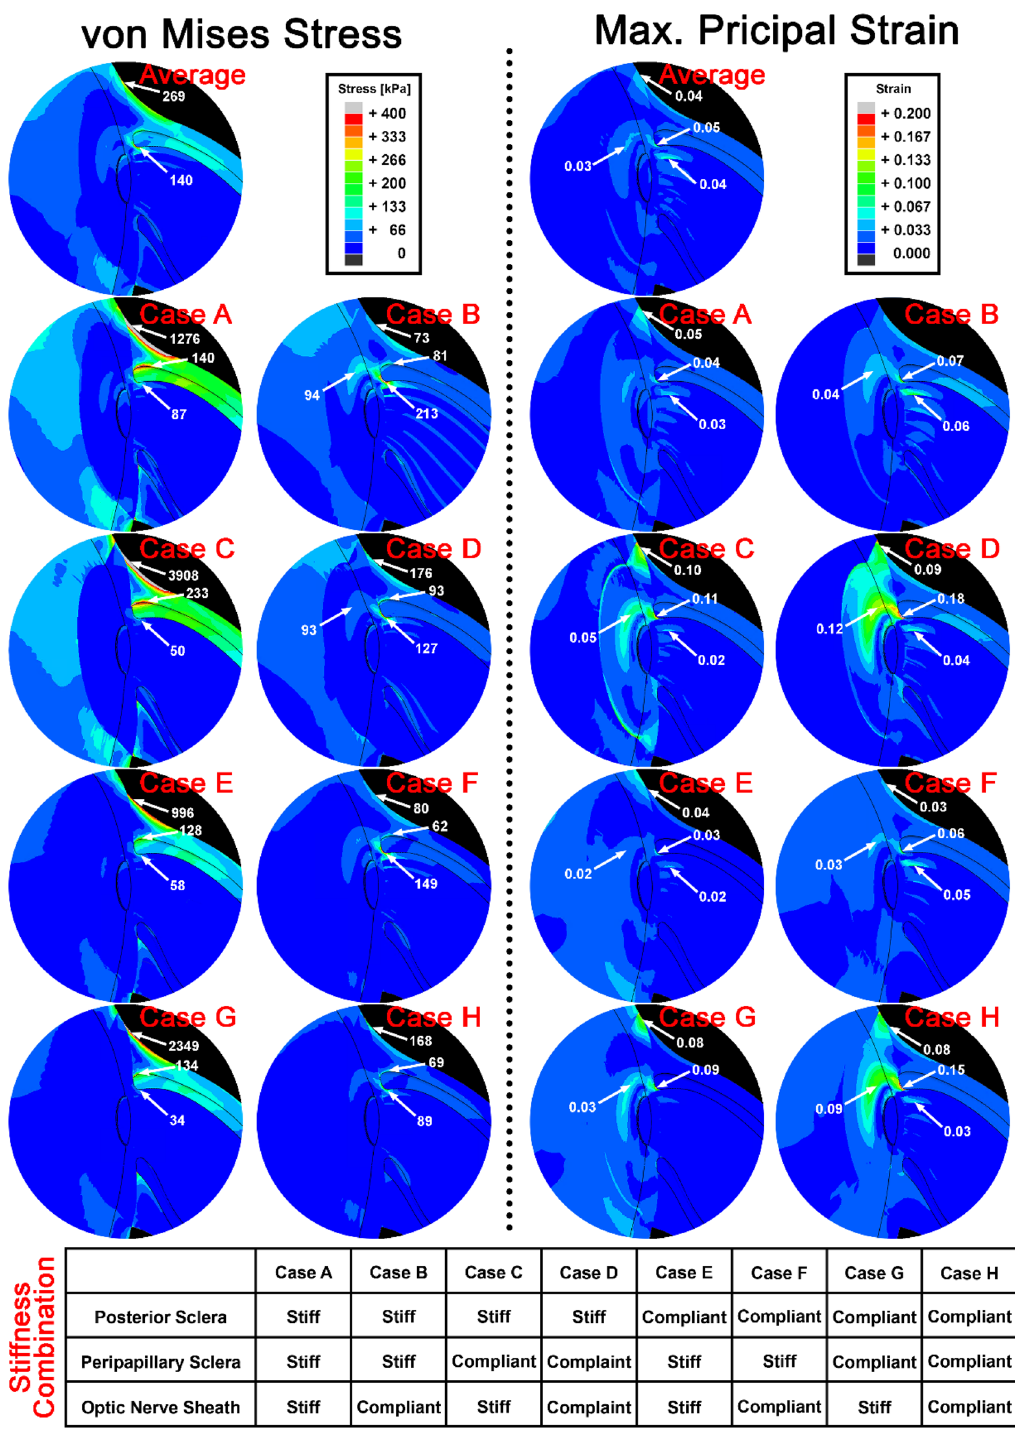
Figure 2. Sensitivity to variations in regional ocular material properties, as implemented by reduced polynomial functions for which the indicated qualities are shorthand, during adduction 6° beyond onset of tethering at 26°. Stiff and compliant material properties were set to 95th and 5th percentile values, respectively, of stress–strain functions measured after preconditioning 43 (details in Table 1). Material properties for regions not noted here were set to average observed reduced polynomial